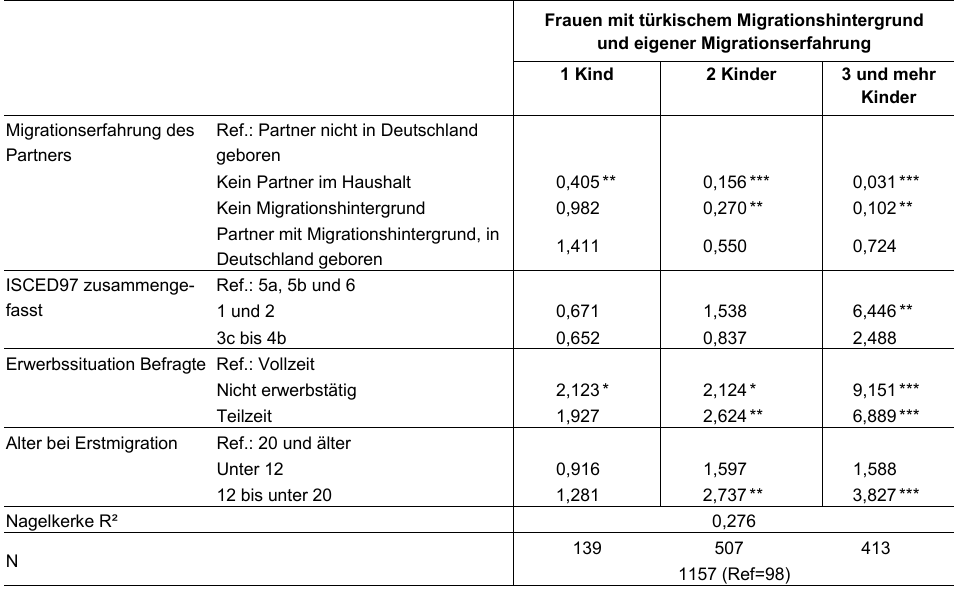
Tabelle 4 : Multinomiale Regression für Frauen mit eigener Migrationserfahrung (Odds Ratio)